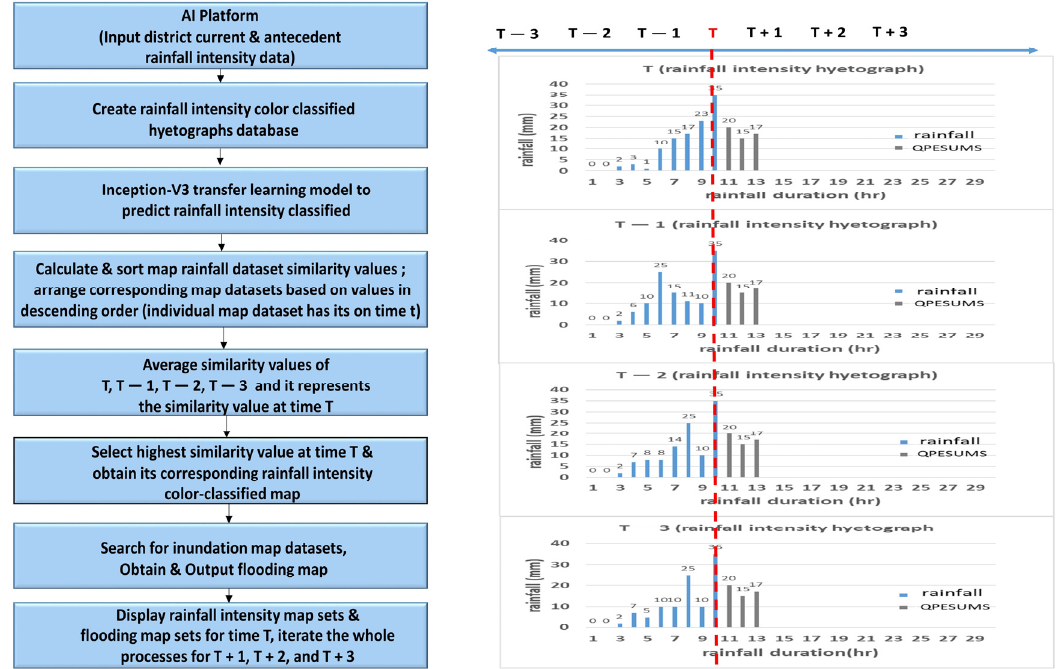
Figure 12. Another approach by introducing Quantitative Precipitation Estimation and Segregation Using Multiple Sensors (QPESUMS) data as the next 3-h predicted rainfall hyetographs and following the methodologies as presented in the left-hand side of the diagram.